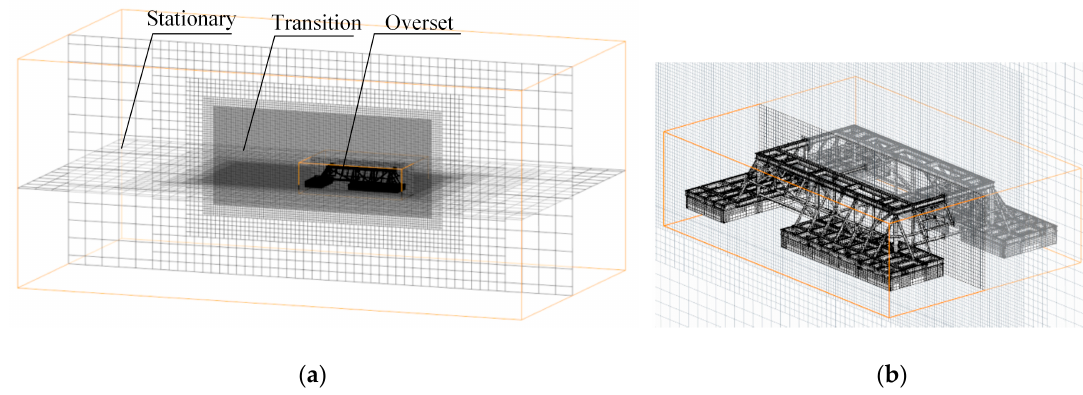
Figure 9. Computational mesh: ( a ) Mesh arrangement in the computational domain, ( b ) Mesh arrangement on the model.